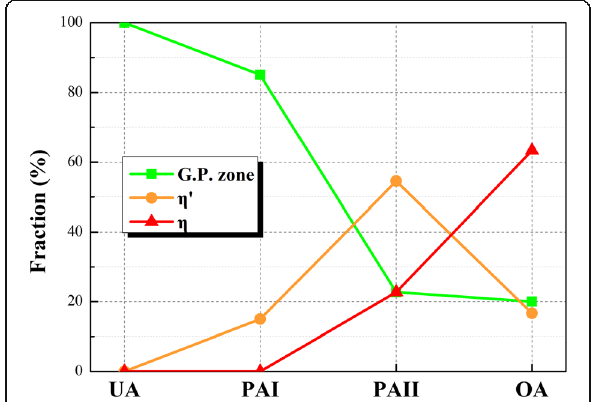
Fig. 5 Statistical fraction of nanoparticles in different second-stage aging